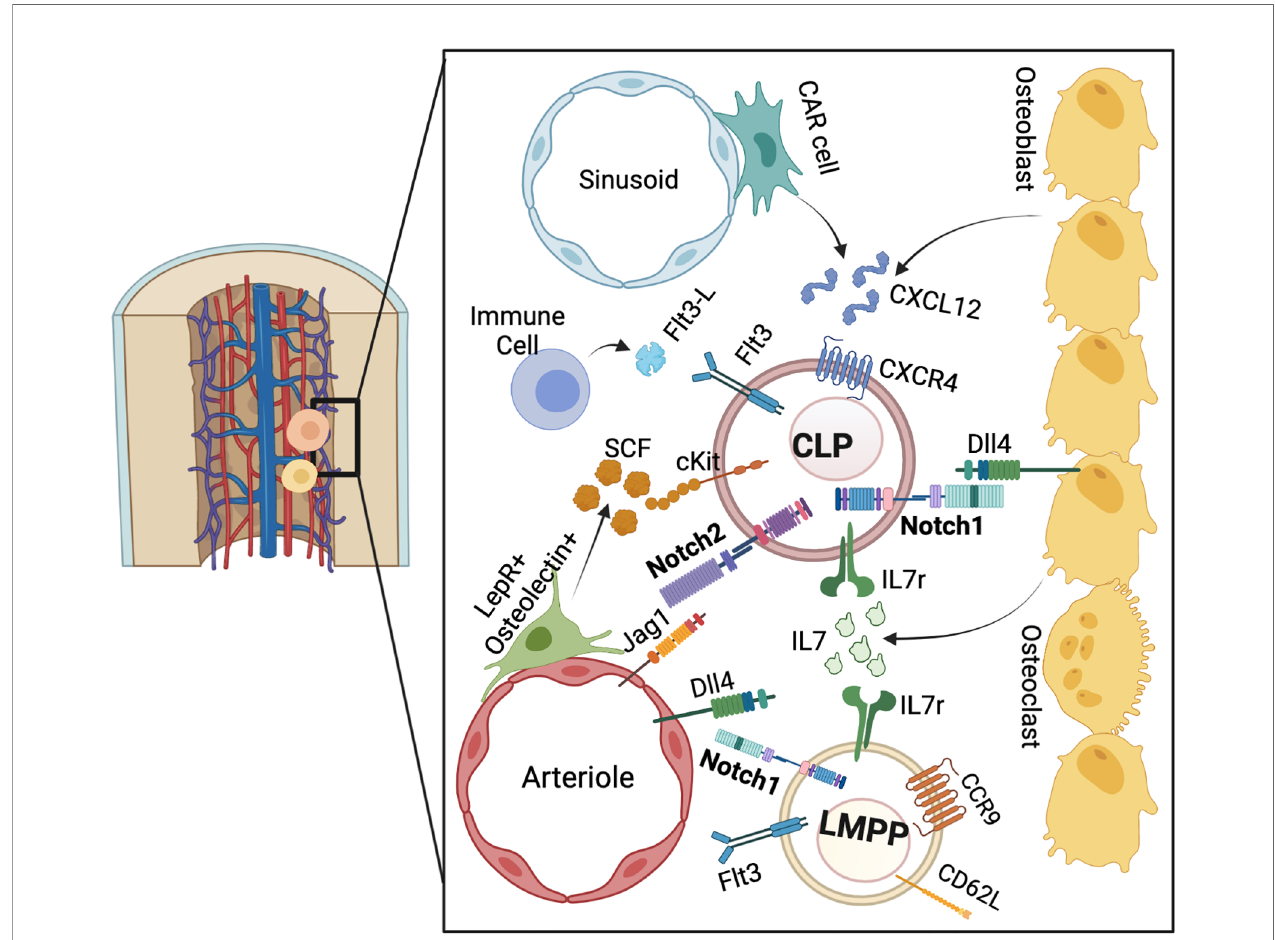
FIGURE 1 | The BM niche for pre-thymic T cell progenitor development. LMPPs and CLPs reside in the endosteal niche. Notch, IL7r, and CXCR4 ligands are derived from the osteoblastic and stromal niche, while SCF is provided from peri-arteriolar cells. Flt3L is provided by mature immune cells. Overall, these signaling pathways converge to stimulate lymphoid progenitors to the T cell